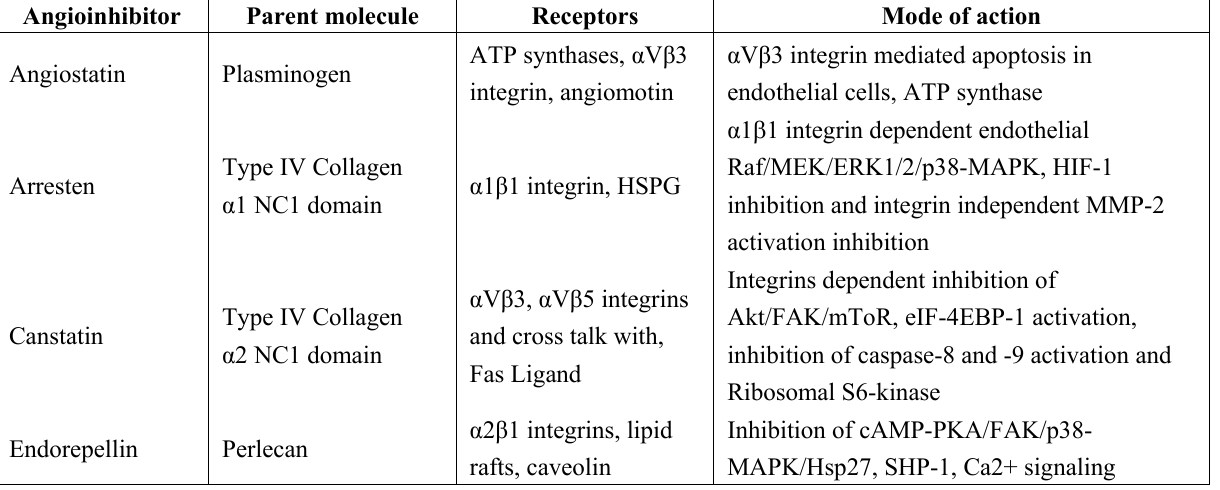
Table 1. Extracellular Matrix derived Endogenous angioinhibitors and their mode of